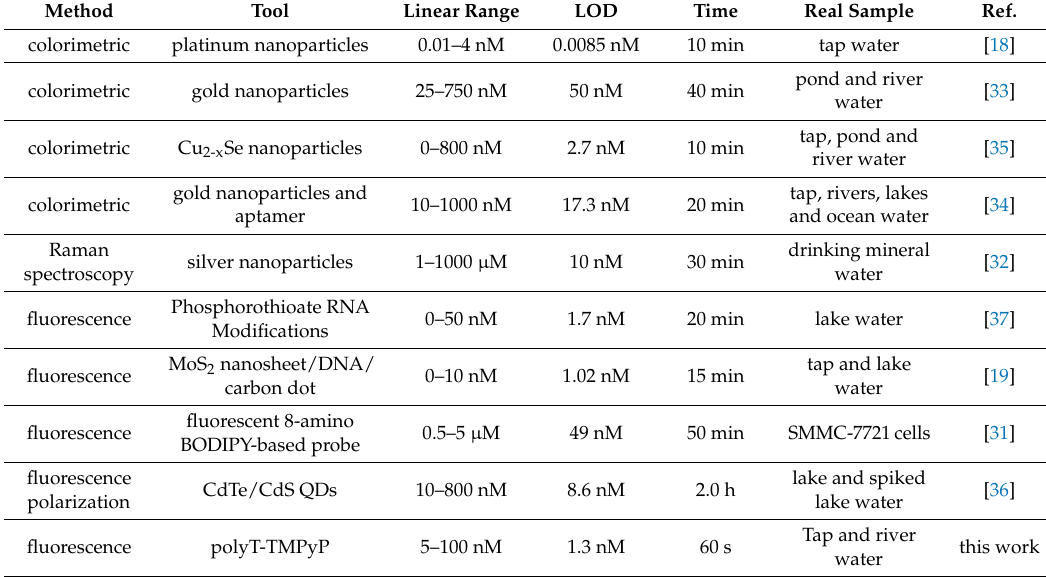
Figure 5. ( A ) Fluorescence spectra of TMPyP-dT 30 in the presence of Hg 2+ with various concentrations: 0, 0.025, 0.1, 0.25, 0.5, 1.0, 2.0 and 4.0 µ M (from a to h). ( B ) Calibration curve for Hg 2+ assay. F 0 and F represent the fluorescence intensities in the absence and presence of Hg 2+ , respectively. The inset shows the linear portion of the curve with Hg 2+ concentrations ranging from 5 nM to 100 nM. The vertical bars designate the standard deviation for the mean of three replicate measurements. Table 1. A comparison of the proposed sensor with other detection